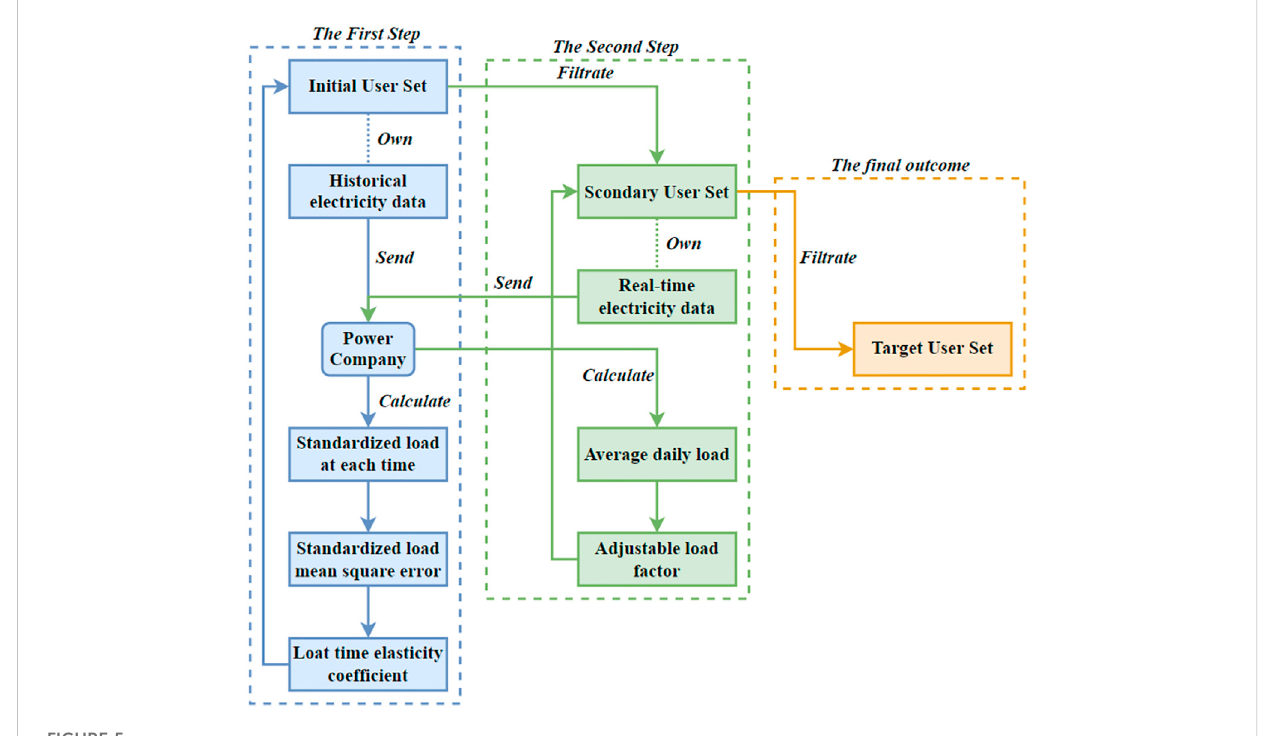
FIGURE 5 Selection frame of participating